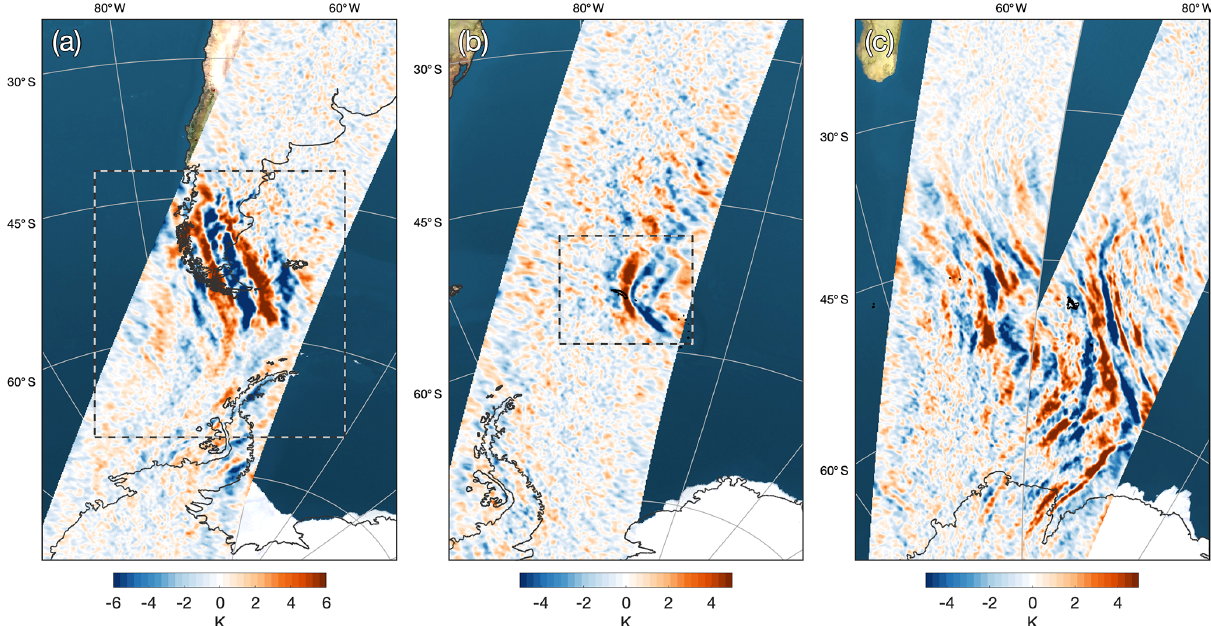
Figure 1. Temperature perturbation measurements along the AIRS scan track at an altitude of z = 40km during overpasses on (a) 1 June over South America and Antarctic Peninsula, (b) 5 July over the island of South Georgia and (c) 28 June 2010 over the Southern Ocean. Panel (c) shows two consecutive overpasses on the same day. This is one vertical layer in a 3-D volume of AIRS temperature measurements between altitudes of 20km and 60km, using the retrieval of Hoffmann and Alexander (2009). Dashed lines in (a) and (b) indicate the regions considered in the 3-D case studies in Figs. 4 and